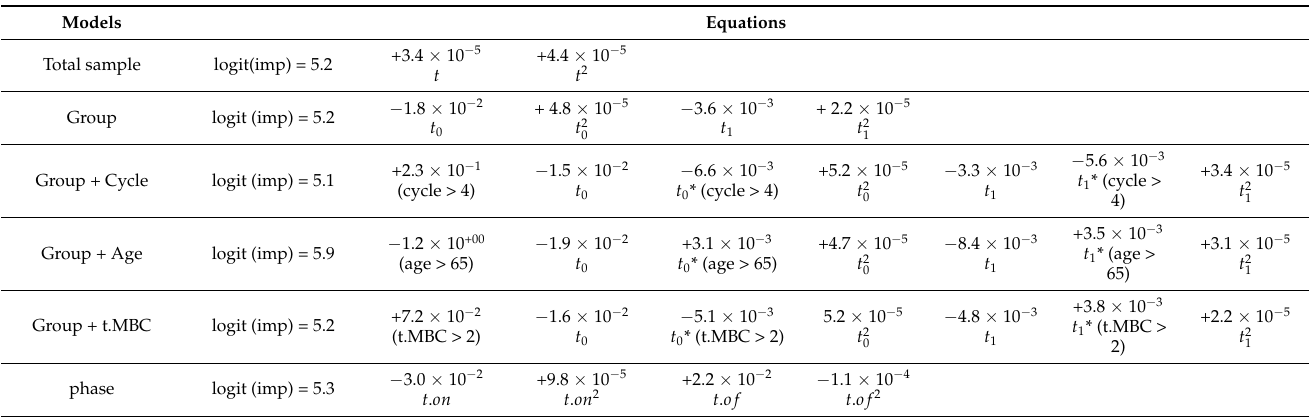
Table A2. Equations of GEE